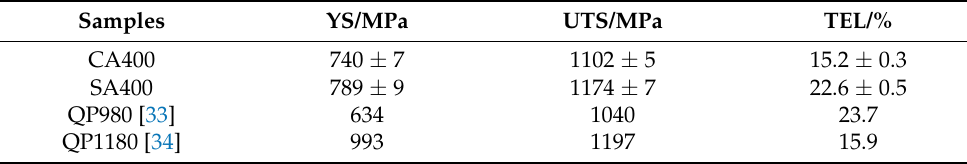
Table 1. Tensile properties of the studied samples.